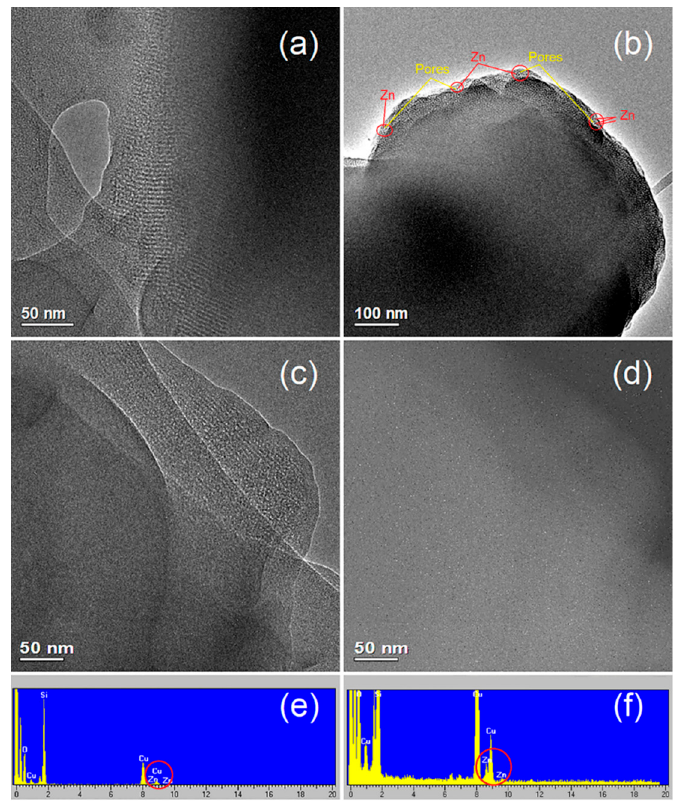
Figure 2. ( a – c ) Bright-field TEM images from different sections of ZnO-SBA-11, ( d ) is the dark-field TEM image of ( c ), ( e ) is the corresponding energy dispersive X-ray spectroscopy (EDX) of ( c , d ), and ( f ) is an enlargement of ( e ).